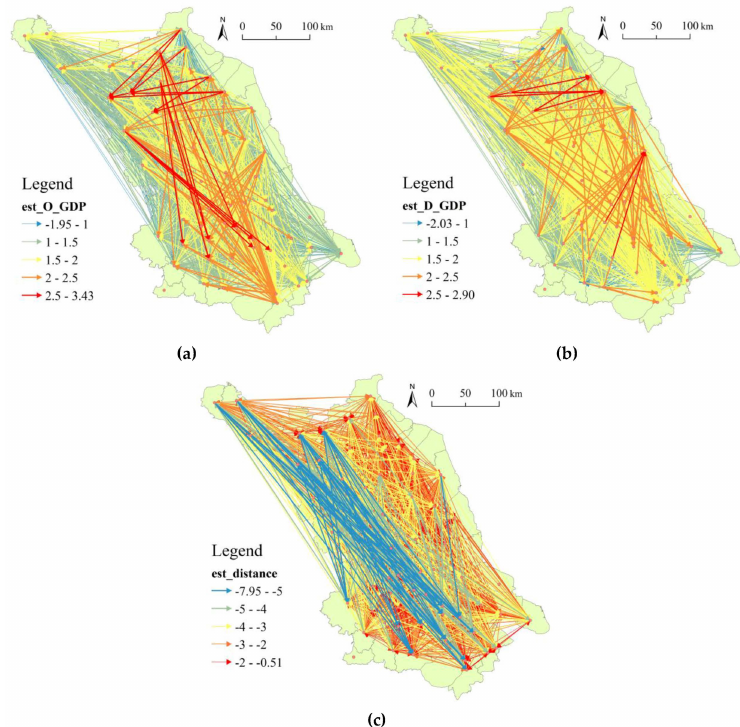
Figure 10. Distributions of three parameter estimations with the GWNBR model. ( a ) OGDP; ( b ) DGDP; ( c ) distance.